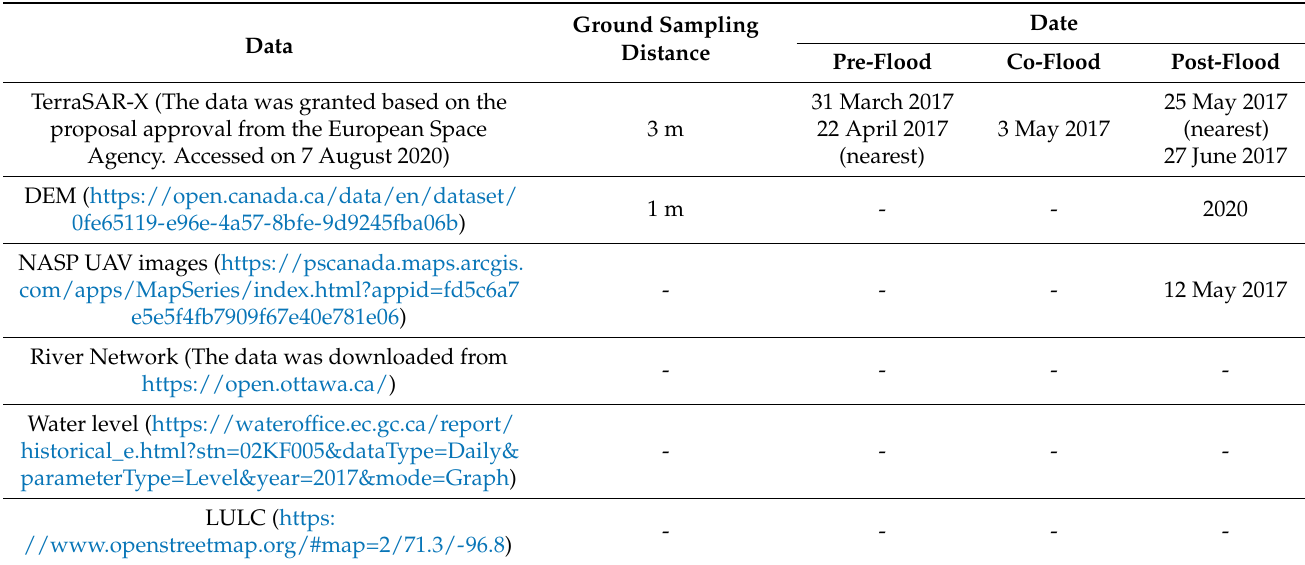
Table 1. Dataset.